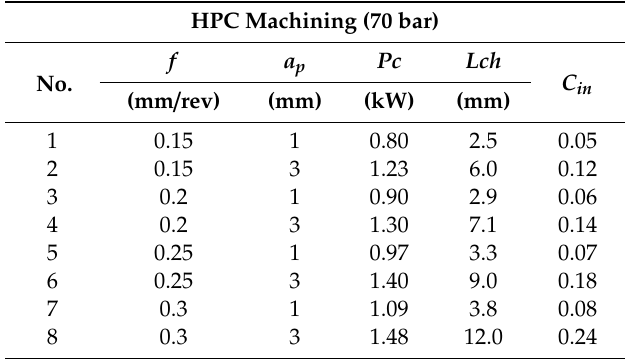
Table 9. Average Pc , Lch and C in values for HPC treatment.